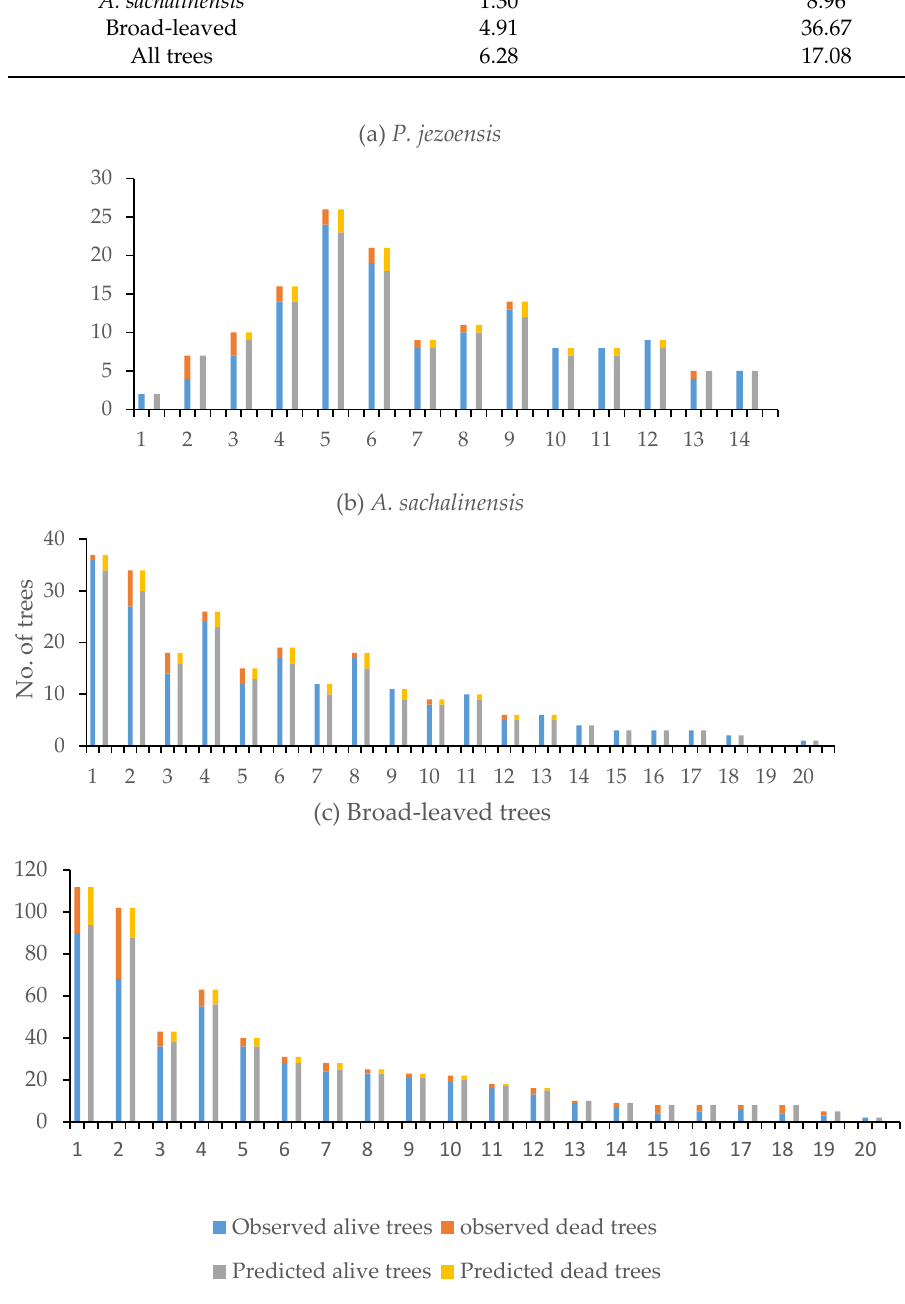
Figure 4. Observed and predicted age class distribution ( a ) P. jezoensis , ( b ) A. sachalinensis, and ( c ) broad-leaved trees.